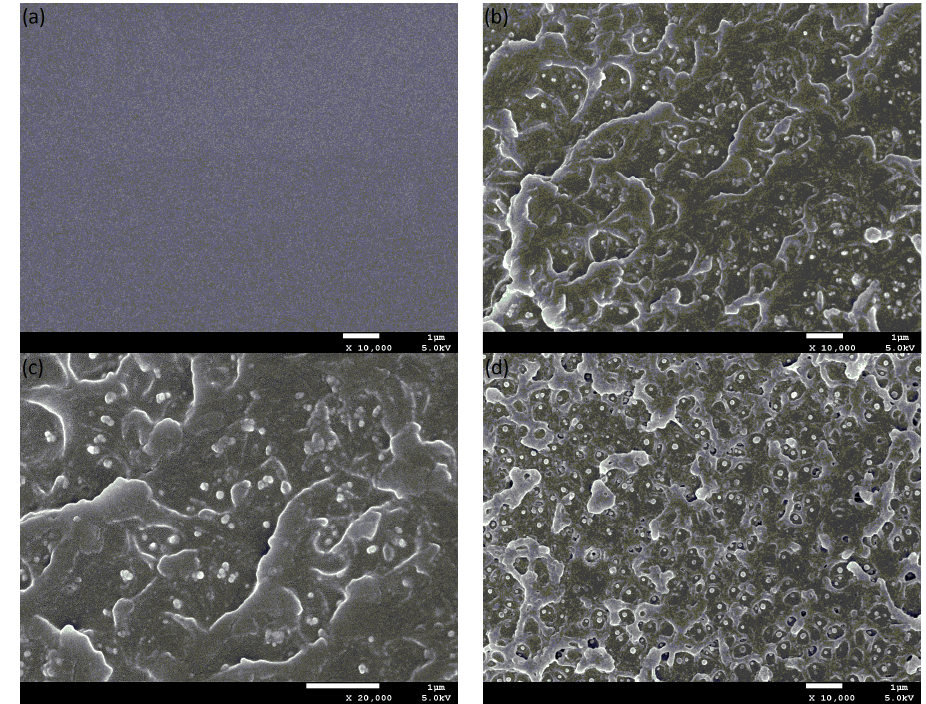
Figure 6. Cross-sectional SEM images of CPEN composite films with different F-BaTiO 3 loading: ( a ) 0 wt %; and ( b ) 20 wt %; ( c ) enlarged details of ( b ); and ( d ) CPEN composite films with 20 wt % pristine BaTiO 3